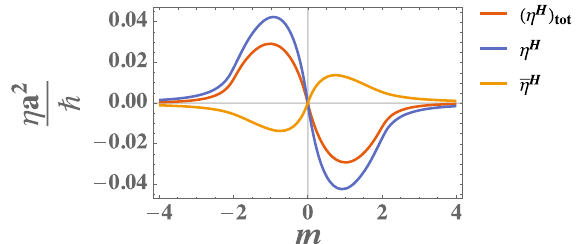
FIG. 5. Hall viscosities in C 4 , η H , η H , ¯ η H , plotted with the total alternative form of the strain generator, with parameters t ¼ t 0 ¼ r ¼ 1 and lattice constant a ¼ 1 . We see much less variation in the plots in this case, while the same features of oddness in m and vanishing in the topologically trivial regimes